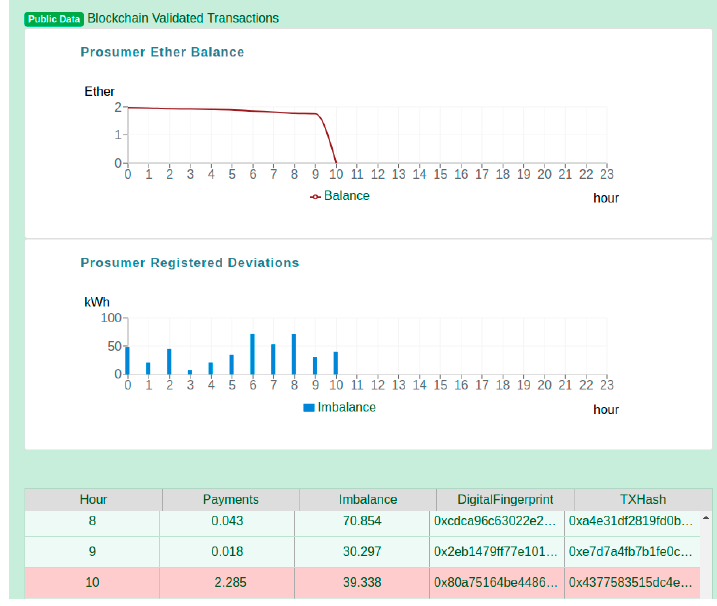
Figure 14. Public data on ZKP inconsistency detected and prosumer penalization.